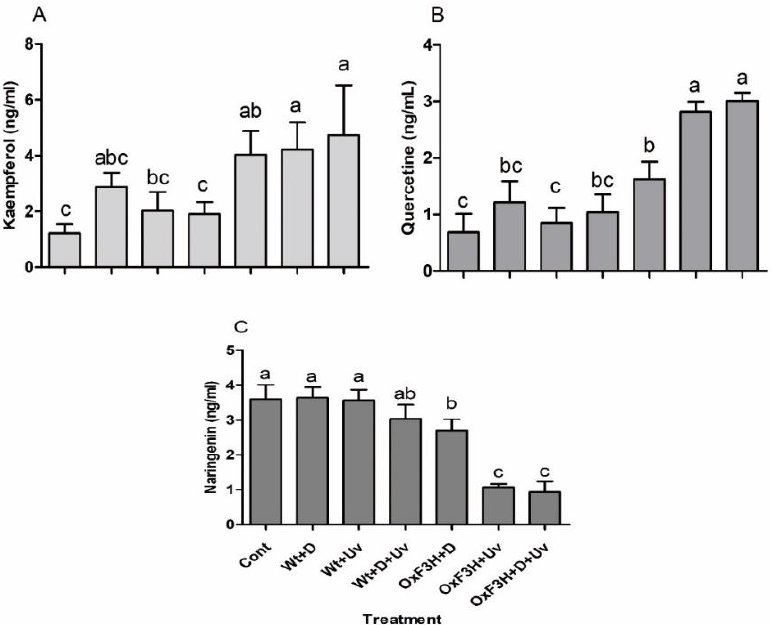
Figure 6. Quantification of flavonoids in wild and transgenic rice plants in response to drought and UV-B radiation stresses. ( A ) Kaempferol, ( B ) quercetin, and ( C ) naringenin accumulation level. Each data point is the mean of three replicates. Error bars represent standard errors. The bars shown with different letters are significantly different from each other as evaluated by DMRT analysis.